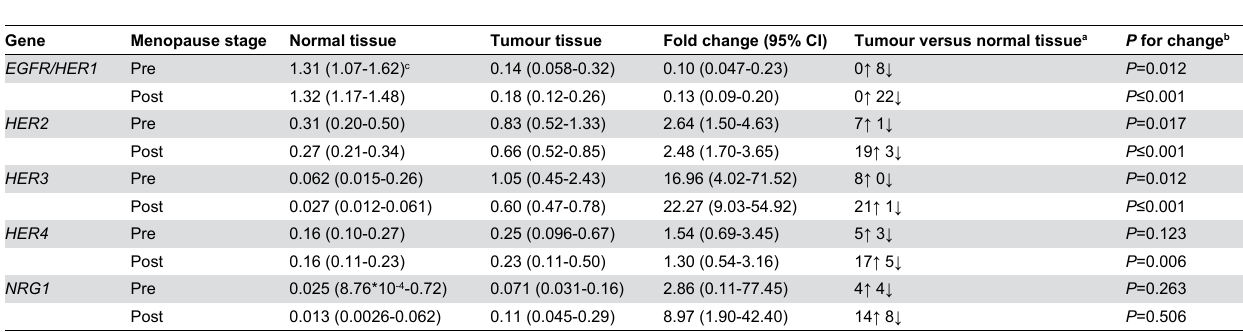
Table 3. HER1-4 and NRG1 levels in normal and breast cancer tissue among postmenopausal patients.